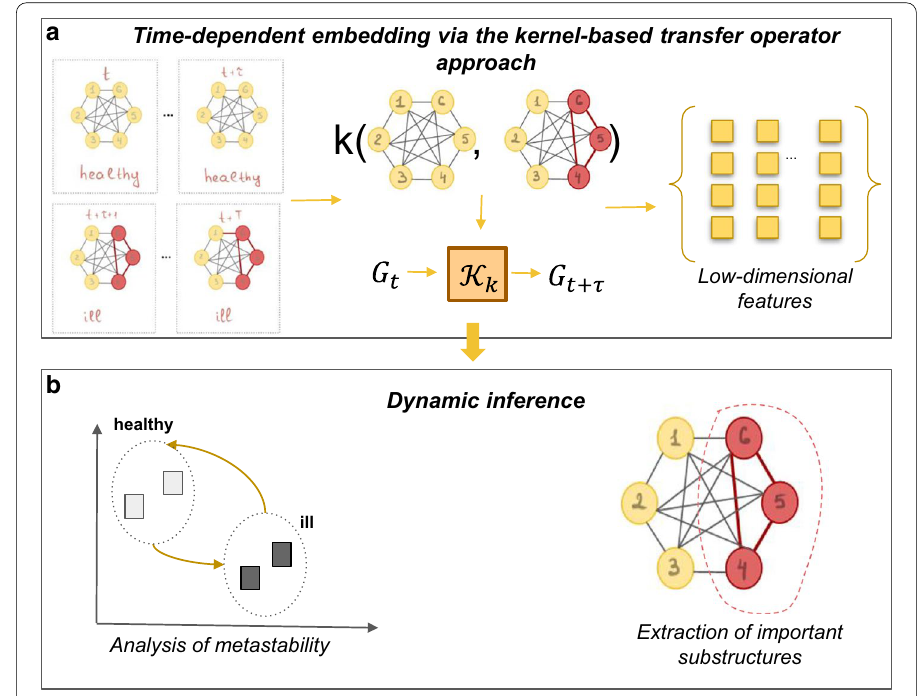
Fig. 2 An illustration of the proposed method and challenges which we aim to overcome. a Learning transfer operators using graph kernels, where k ( · , · ) is a graph kernel and K k is the Koopman operator. b In the learned embedding space it is possible to detect metastable states and to determine distinct